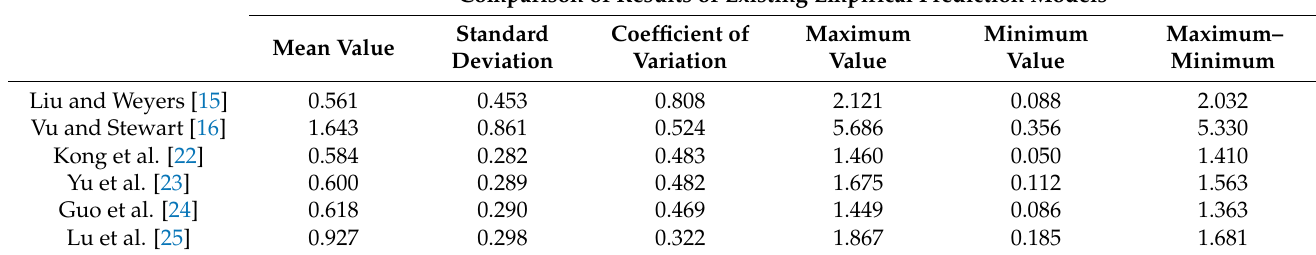
Figure 2. Comparison and analysis of the experimental results and the prediction results of the current empirical model. ( a ) Liu and Weyers [15]. ( b ) Vu and Stewart [16]. ( c ) Kong et al. [22] ( d ) Yu et al. [23] ( e ) Guo et al [24] . ( f ) Lu et al. [25]. Table 3. Comparison of the results of empirical models for corrosion rate prediction based on experimental data. Comparison of Results of Existing Empirical Prediction